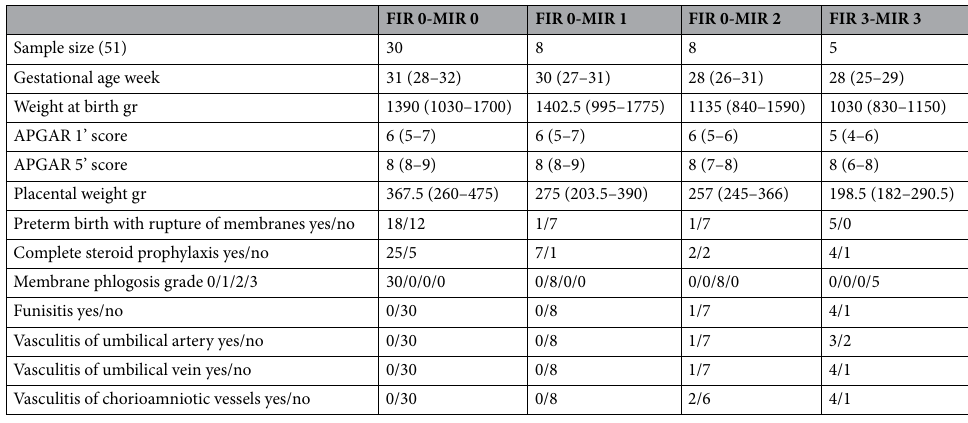
Table 1. Clinical data. Continuous data are reported as median and interquartile